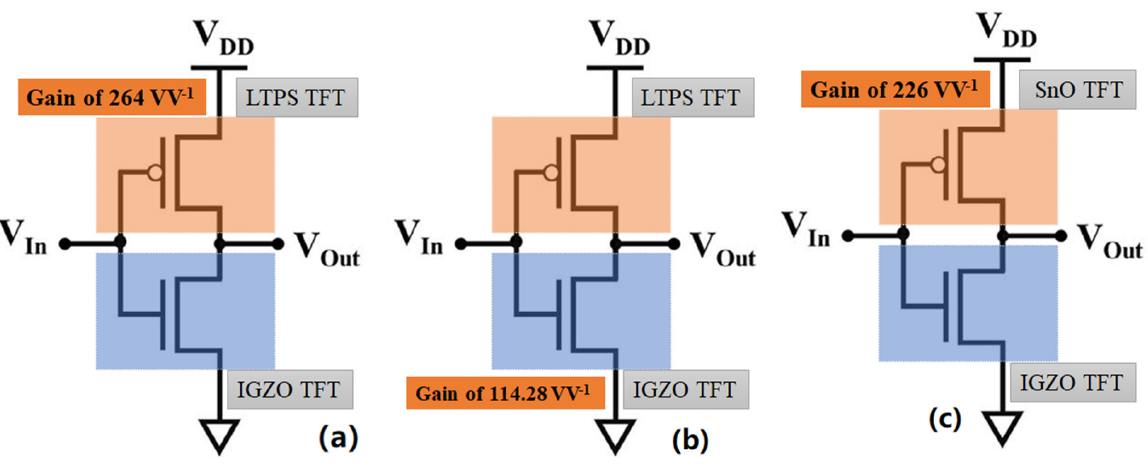
Figure 12. Inverter with LTPO: ( a ) Inverter of 264 VV − 1 gain, ( b ) Inverter of 114.28 VV − 1 gain, and ( c ) Inverter of 226 VV − 1 gain.